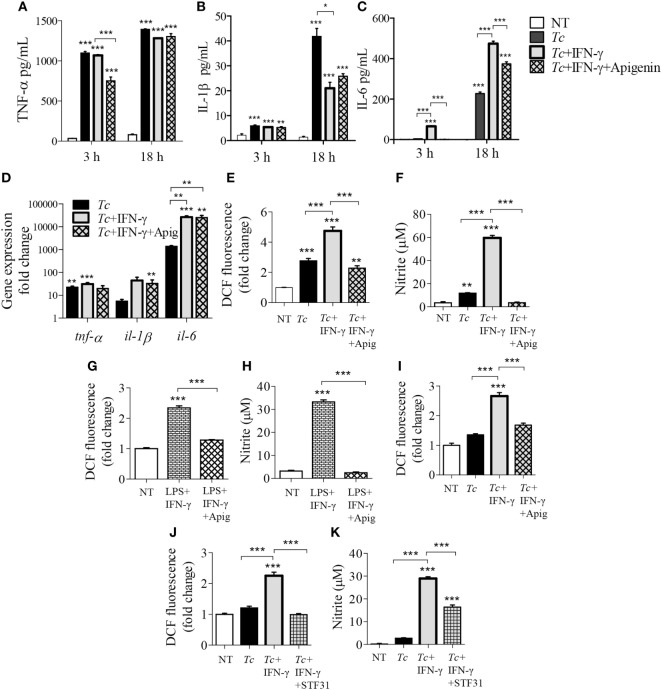
Modification of cytokine, reactive oxygen species (ROS), and nitric oxide (NO) response of activated macrophages by glucose uptake. RAW 264.7 macrophages were incubated for 3 h or 18 h with Trypanosoma cruzi (Tc) in the presence or absence of IFNγ and apigenin glucose transport 1 inhibitor (A–C). Shown are quantification of TNF-α (A), IL-1β (B), and interleukin (IL)-6 (C) release by an enzyme linked immunosorbant assay and gene expression analysis of these cytokines by reverse transcription quantitative PCR (D). Intracellular ROS (E) and nitrite release (F) in macrophages incubated for 18 h were determined as in Figure 5. (G,H) RAW 264.7 macrophages were incubated with lipopolysaccharide (LPS) + IFNγ (± apigenin) for 18 h and analyzed for ROS (G) and nitrite levels (H). (I) Bone marrow-derived murine macrophages were incubated with Tc (±IFNγ and apigenin) for 18 h, and intracellular ROS was determined as above. (J,K) RAW264.7 macrophages were infected with Tc in the presence or absence of IFNγ and STF31 (glucose transporter 1 inhibitor) for 18 h, and intracellular ROS (J) and nitrite release (K) were measured. Data are shown as mean ± SEM of ≥3 biological replicates. ANOVATukey *p < 0.05, **p < 0.01, ***p < 0.001 when compared to no-treatment controls unless marked by a line over comparing groups.